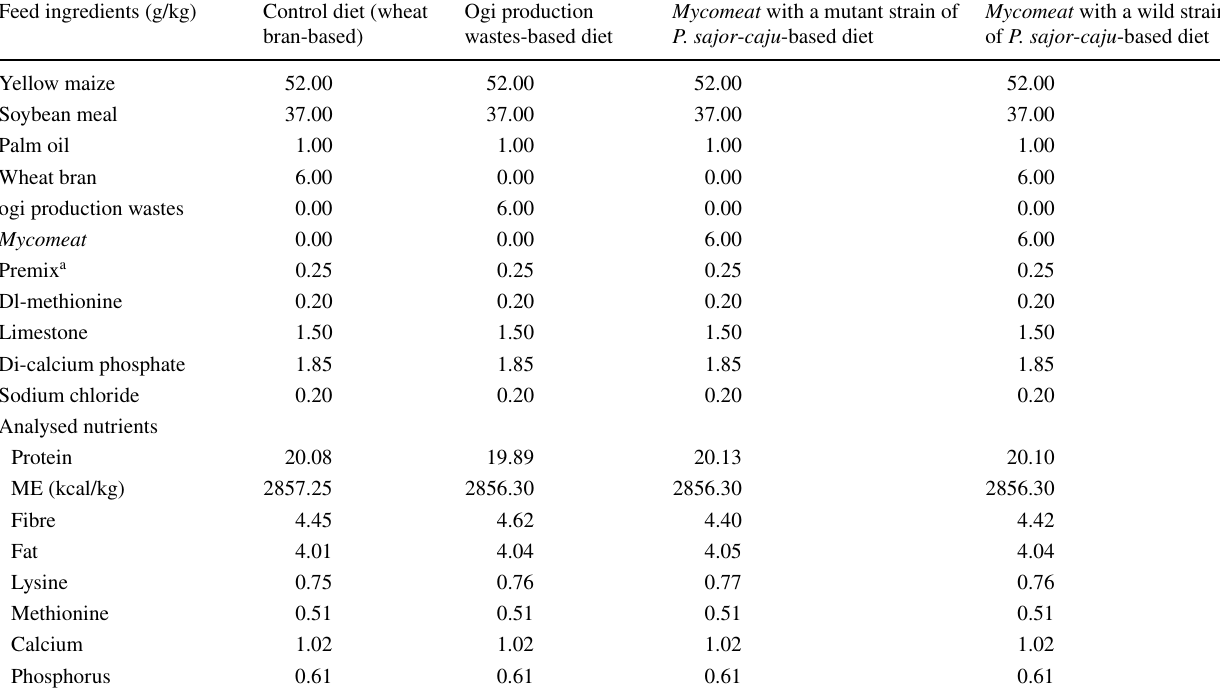
Table 1 Gross nutrient composition of experimental